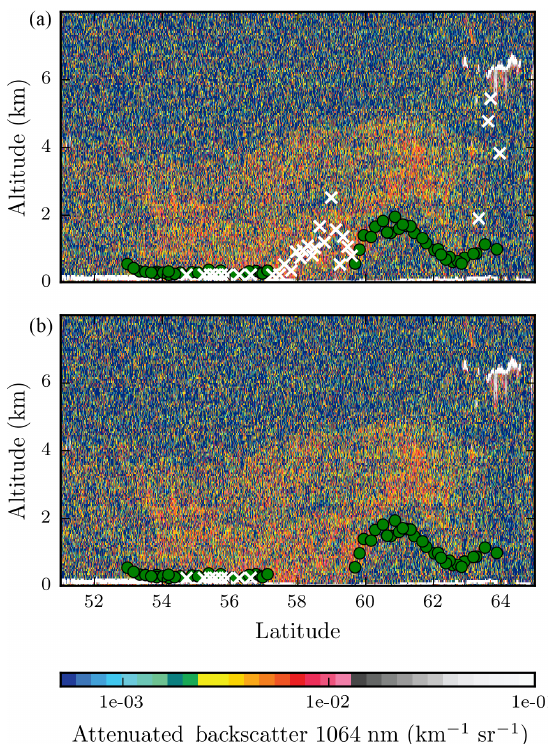
Figure 9. CALIOP lidar backscatter cross section of a track falling within the region of interest over the 2010 Russian wildfire plume on 8 August 2010. (a) Green dots and white crosses are GOME-2A pixels falling within 100km of the CALIPSO ground track – green dots represent converged aerosol layer heights, and white crosses represent the aerosol layer heights at the last iteration for pixels that do not converge to a solution. These retrieved altitudes are reported in km above ground surface. (b) Retrieval results are presented for pixels for which the prefit method retrieves both τ (cid:48) a and τ (cid:48)